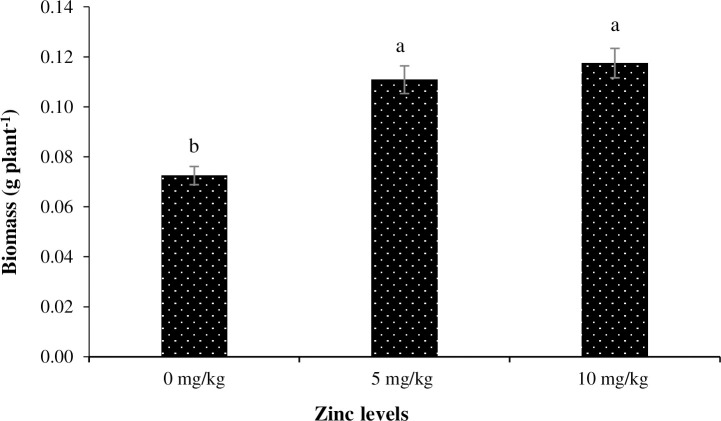
The influence of different Zinc (Zn) levels on dry biomass production of Basil (Ocimum basilicum L.).The vertical bars are means ± standard errors. Any two means having different letters are statistically different from each other (p < 0.05).